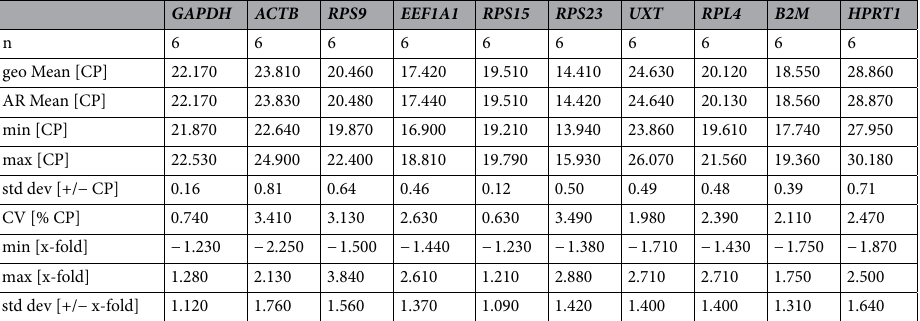
Table 4. Analysis of parameters based quantitative cycling points (CP) for 10 candidate RGs in LAC. N = number of samples, geo Mean[CP] = geometric mean of CP; ar Mean[CP] = arithmetic mean of CP; min [CP] and max [CP] = extreme values of CP; Std dev [± CP] = standard deviation of the CP; CV [%CP] = coefficient of variation expressed as a percentage on the C p values; min [x-fold] and max [x-fold] = extreme values of expression levels expressed as absolute x-fold over or under coefficient; std dev[± x-fold] = standard deviation of the absolute regulation coefficients.